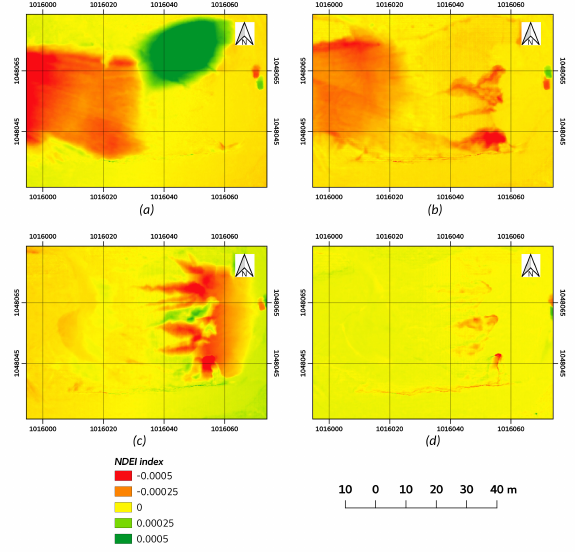
Figure 9. NDEI index, land surface changes for time